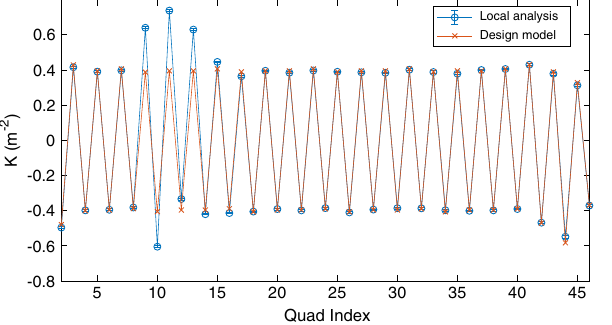
FIG. 9. Gradients for L3 quadrupoles obtained from trajectory scan data with the local analysis are compared to the design model